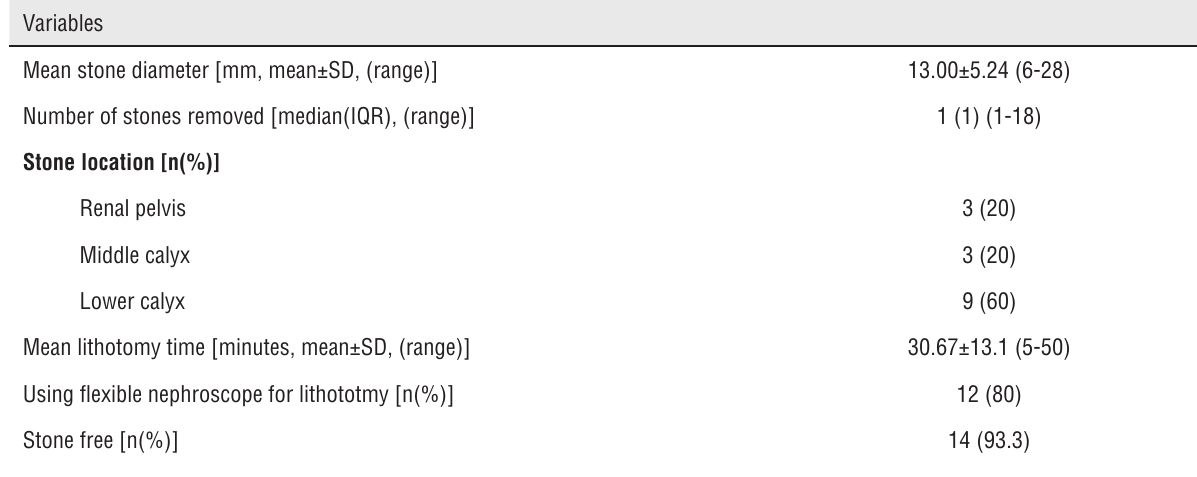
Table 3 - Sstone characteristics of